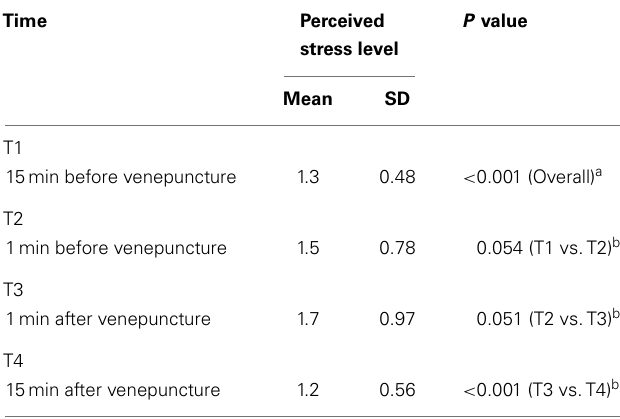
Table 2 | Change of perceived stress level (PSL) at four-time measures of 58 workers .